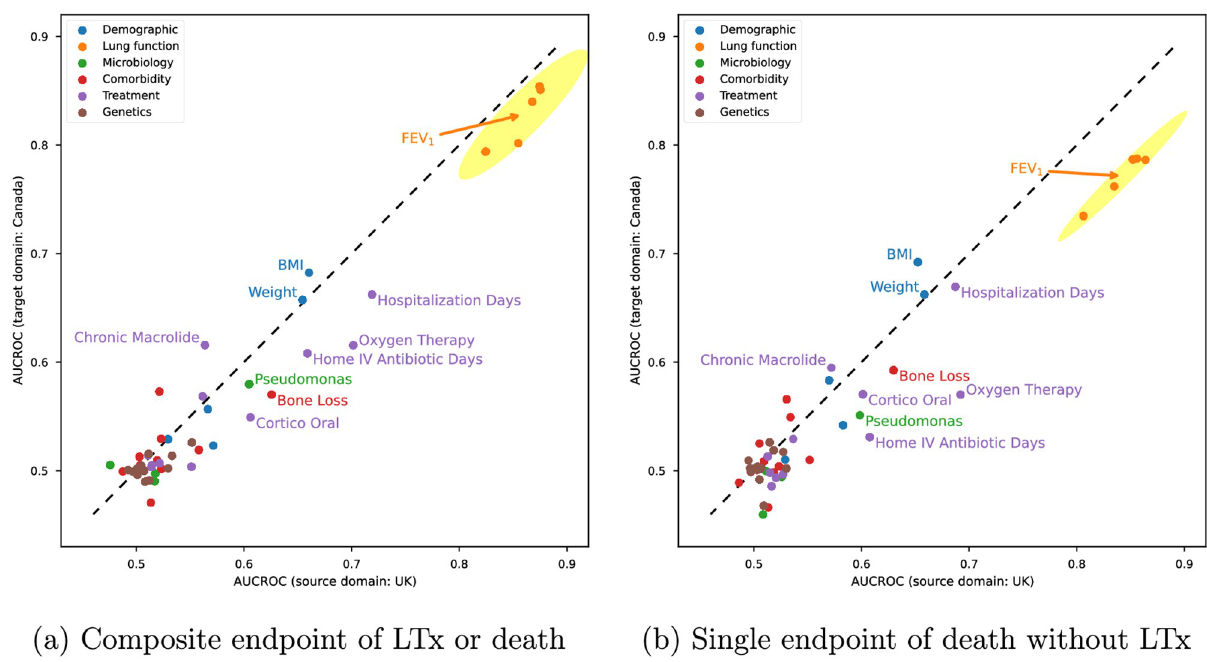
Fig 2. Diagnostic accuracy of individual variables in the UK and Canadian CF cohorts. The ML model constructed by AutoPrognosis was trained with one single feature variable as input iteratively on the UK cohort. The AUCROC score was used as the proxy of diagnostic accuracy and was measured with ten-fold cross-validation. The Canadian CF cohort was used as the external validation set in each fold. Feature variables were colored based on their category, and their locations were determined by the average AUCROC score achieved by their associated models on the two populations. Feature variables with AUCROC score above 0.6 [25] were considered to be predictive of high-risk patients and were annotated with their variable